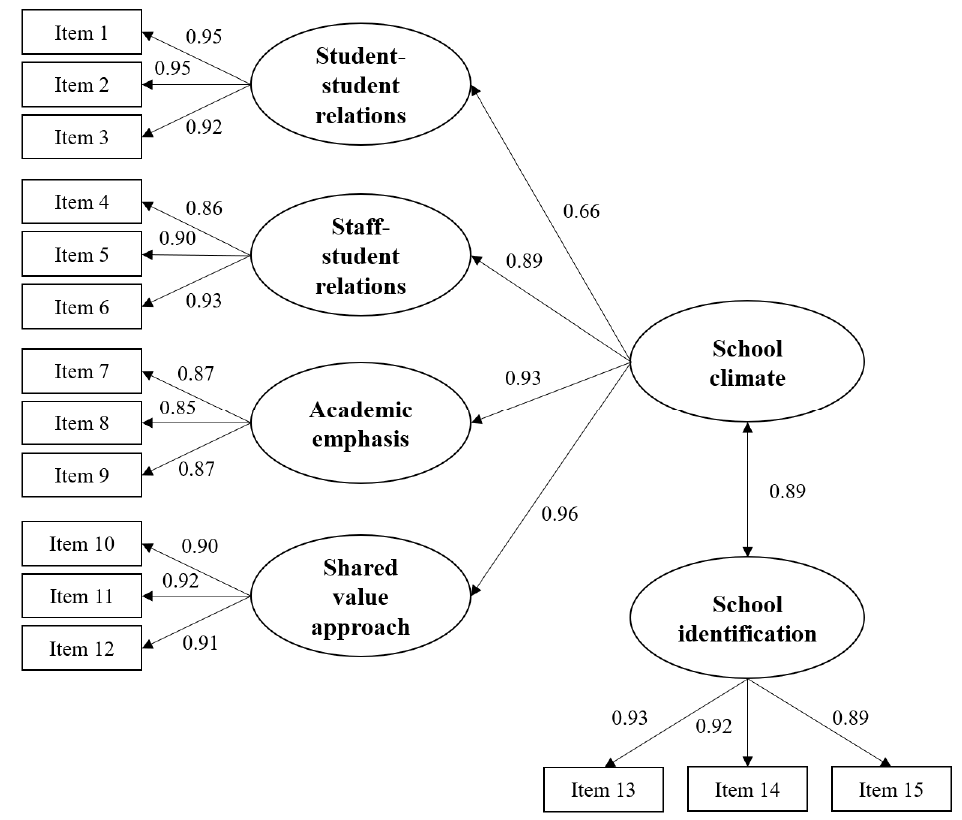
Figure 1. Confirmatory factor analysis of the second-order factor structure of the SCASIM-St15 (Note. Standardized coefficients are reported; all factor loadings are statistically significant with p -value < 0.001).